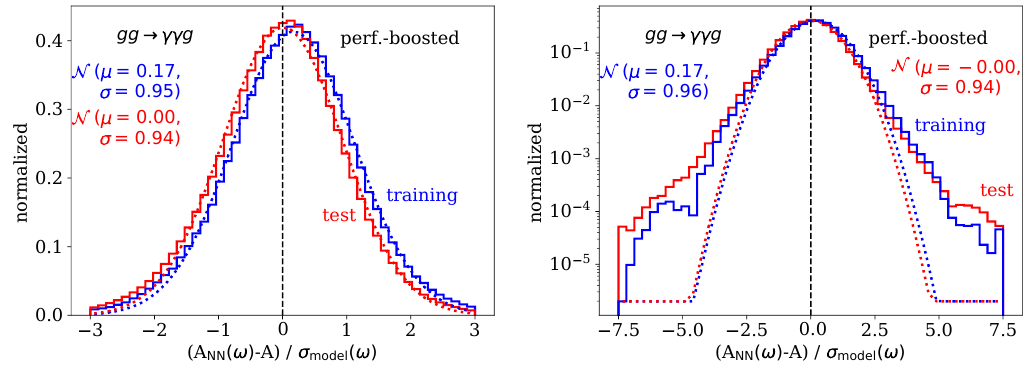
Figure 8: Pulls for the performance-boosted BNN, defined in Eq.(17) and evaluated on the training and test data. The two panels show the same results on a linear and a logarithmic axis. All curves can be compared to the BNN results without boosting in Fig. 4 and the loss-boosted results in Fig.